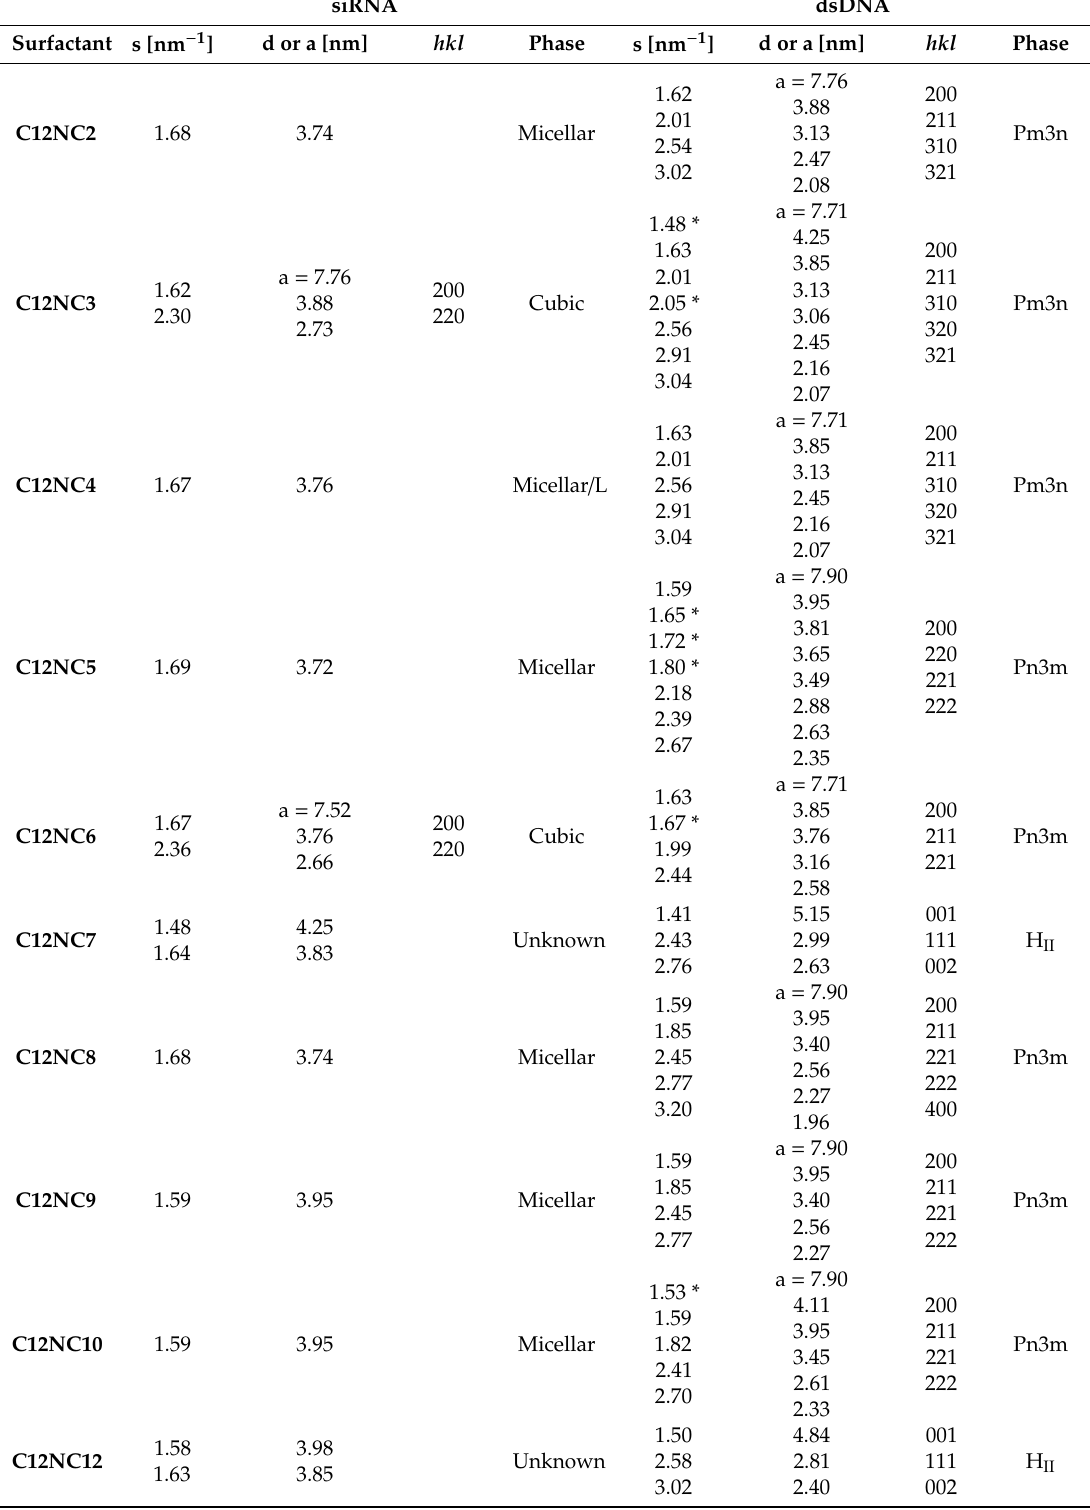
Table 1. Analysis of SR-SAXS data and structural phases proposed for dsDNA–C12NCn and siRNA–C12NCn